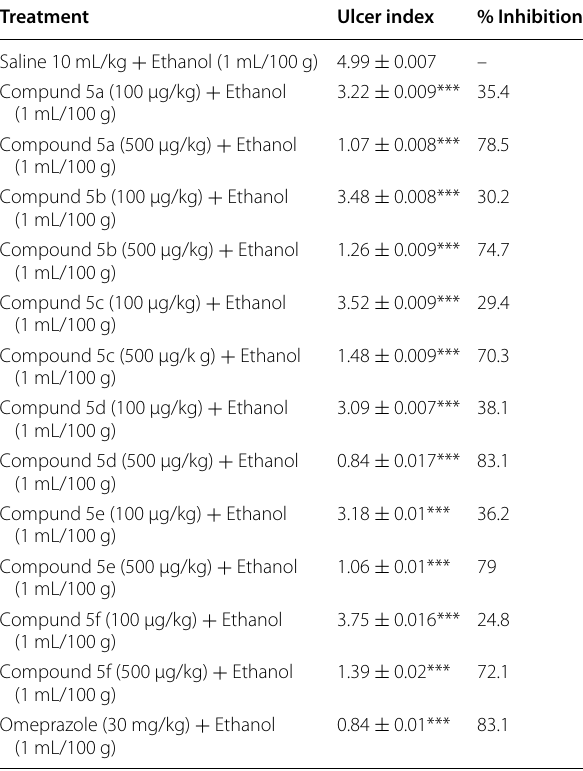
Table 1 Protective effect of compounds and omeprazole against ethanol-induced gastric ulcers in